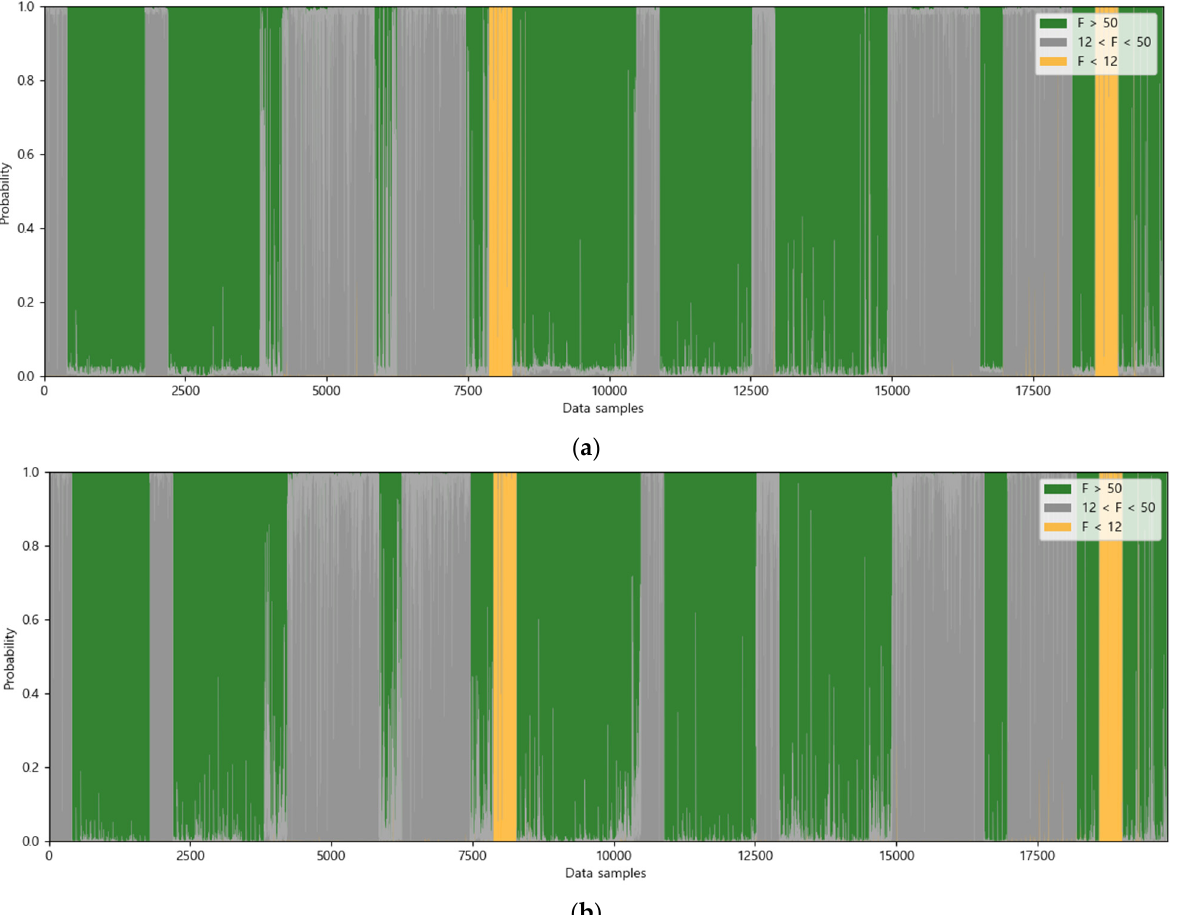
Figure 7. Prediction results by classification model (step 1: particle size): ( a ) support vector machine; ( b ) Light GBM.